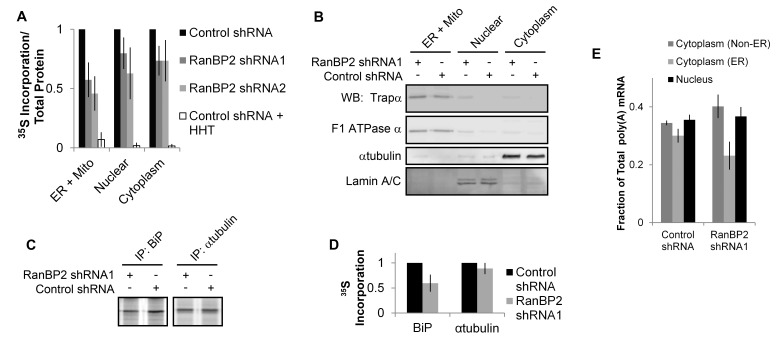
RanBP2 is required for the efficient translation of secretory proteins.(A–B) U2OS cells were treated with various lentiviruses, then 4 d post-infection cells were incubated in media containing [35S]-methionine/cysteine for 20 min. The cells were lysed and subfractionated by differential detergent treatments and centrifugation steps to produce three fractions: one enriched in nuclear proteins, a second containing ER and mitochondrial proteins, and the remaining cytoplasmic proteins. (A) The ratio of [35S]-incorporation to total protein from each fraction was measured and normalized to control cells. Each bar represents the average and standard error of three independent experiments. Note that radioactive incorporation into the fractions was blocked when cells were pre-treated with the translation inhibitor homoharingtonine (HHT) 15 min prior to [35S]-methionine/cysteine labeling, demonstrating that the fractions do not contain free (i.e., unincorporated) labeled amino acids. (B) Various cell fractions from knockdown and control cells were analyzed by immunoblot using antibodies against either Trapα (a resident ER protein), F1 ATPase α (a mitochondrial protein), α-tubulin (a cytoplasmic protein), and lamin A/C (a nuclear protein). (C–D) U2OS cells were treated with various lentiviruses, then 4 d post-infection cells were incubated in media containing [35S]-methionine/cysteine for 20 min. Cells were lysed and BiP and α-tubulin were immunoprecipitated with specific antibodies. The precipitates were then separated by SDS-PAGE and visualized by autoradiography. Band intensities were measured by densitometry, then normalized to control cells and the average and standard error between three independent experiments were plotted (D). (E) U2OS cells were treated with various lentiviruses, then 4 d post-infection cells were either immediately fixed to visualize cytoplasmic and nuclear poly(A) mRNA, or briefly permeabilized with digitonin to remove all cytoplasmic mRNA that was not anchored to the ER, and then fixed. Poly(A) mRNA was visualized by FISH staining with fluorescent oligo-dT probes and the fraction of fluorescence intensity associated with each compartment was calculated for at least 30 cells in a single experiment. Each bar represents the average and standard error between three separate experiments.